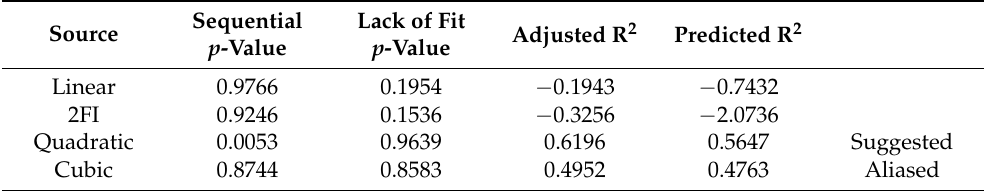
Table 4. Fit summary for Turbidity response